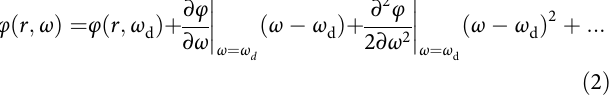
polarization. Figure 1c con fi rms the results predicted by Eq. 3. a 90-degree rotation imparts a π phase shift without affecting group delay (slope) and group delay dispersion